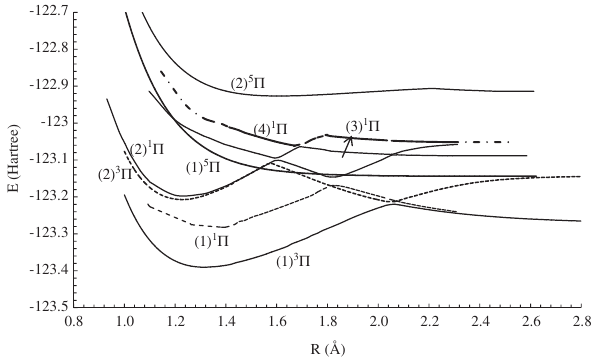
Figure 3: Potential energy curves of the electronic states 1,3,5 Π of the molecule BF.